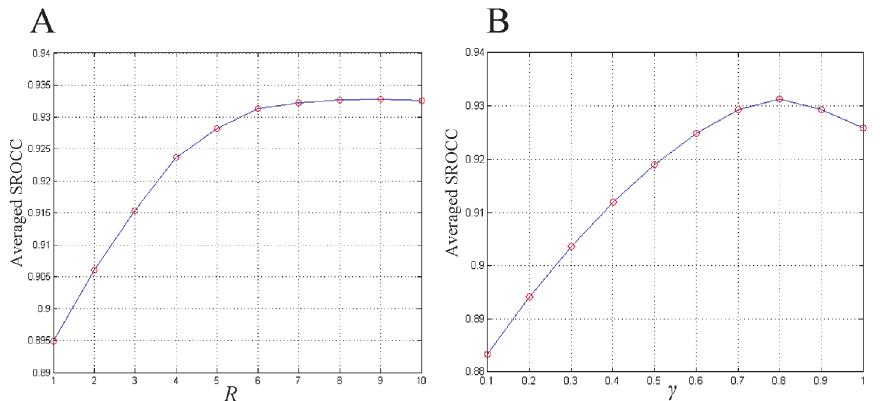
Fig 8. Plots of averaged SROCC values versus parameter values. (A) Impact of parameter R . (B) Impact of parameter γ .